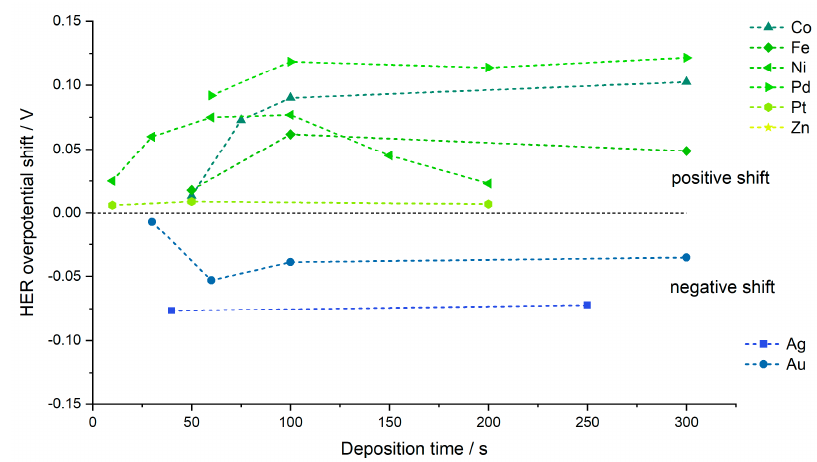
Figure 6. The HER overpotential shifts of considered M@rGO catalysts as a function of electrodeposition time.